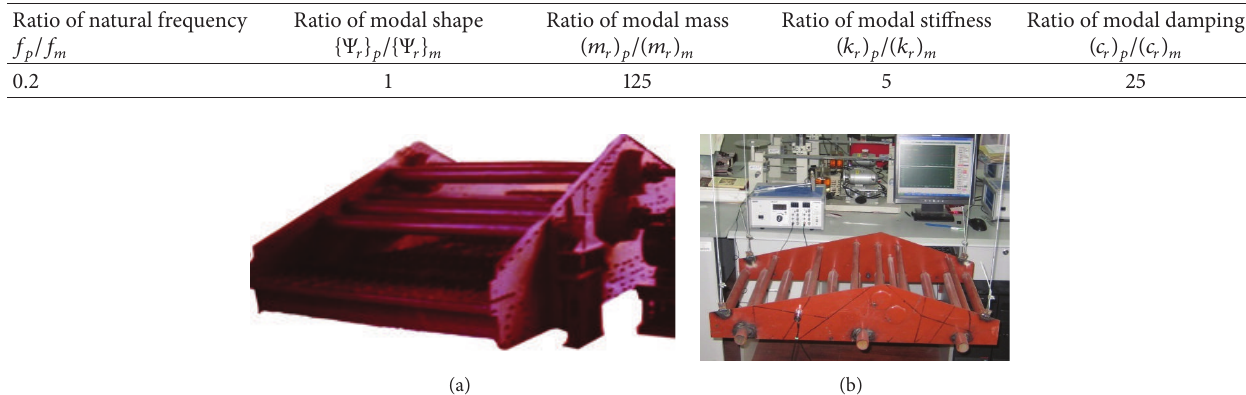
Table 1: The similarity ratios of the modal parameters of the large vibrating screen.